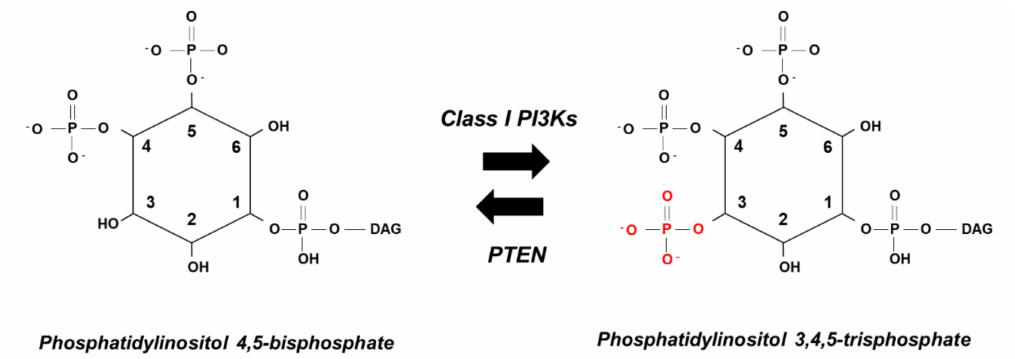
Figure 3. Schematic representation of the opposite action of class I PI3Ks and PTEN. 3. PI3Ks, PtdIns(3,4,5) P 3 , and Akt in